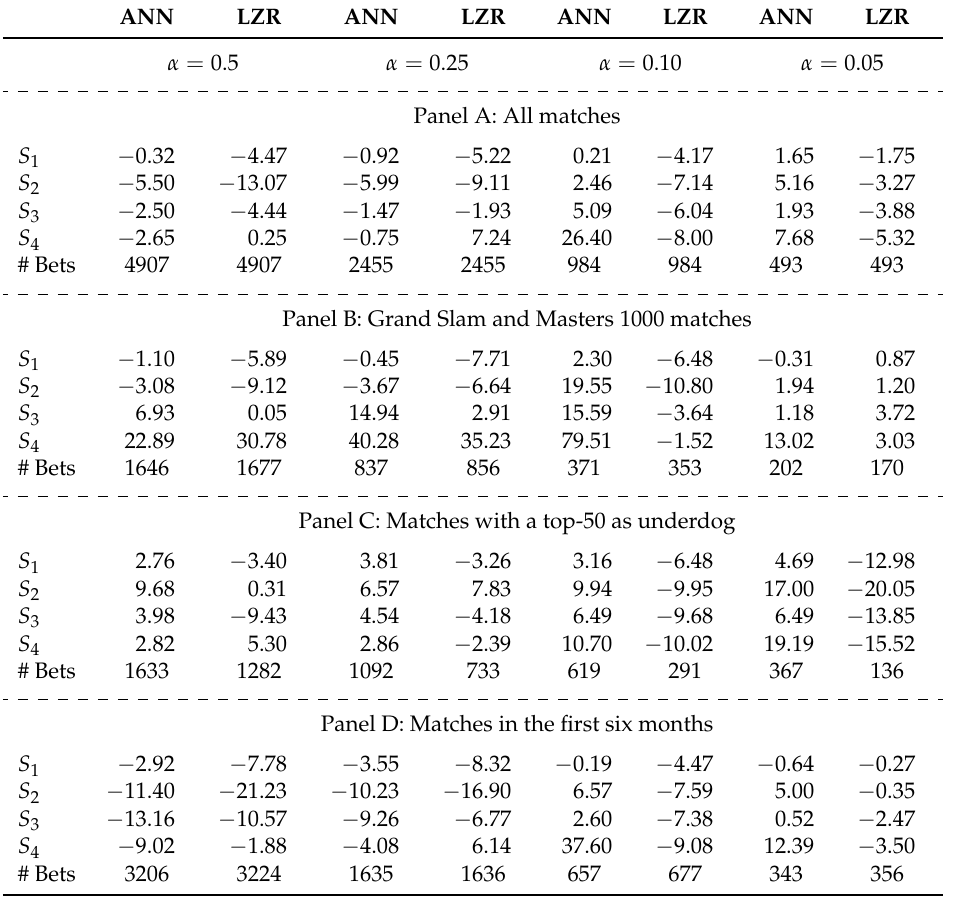
Table 4. ANN and LZR ROI (in %) for betting on